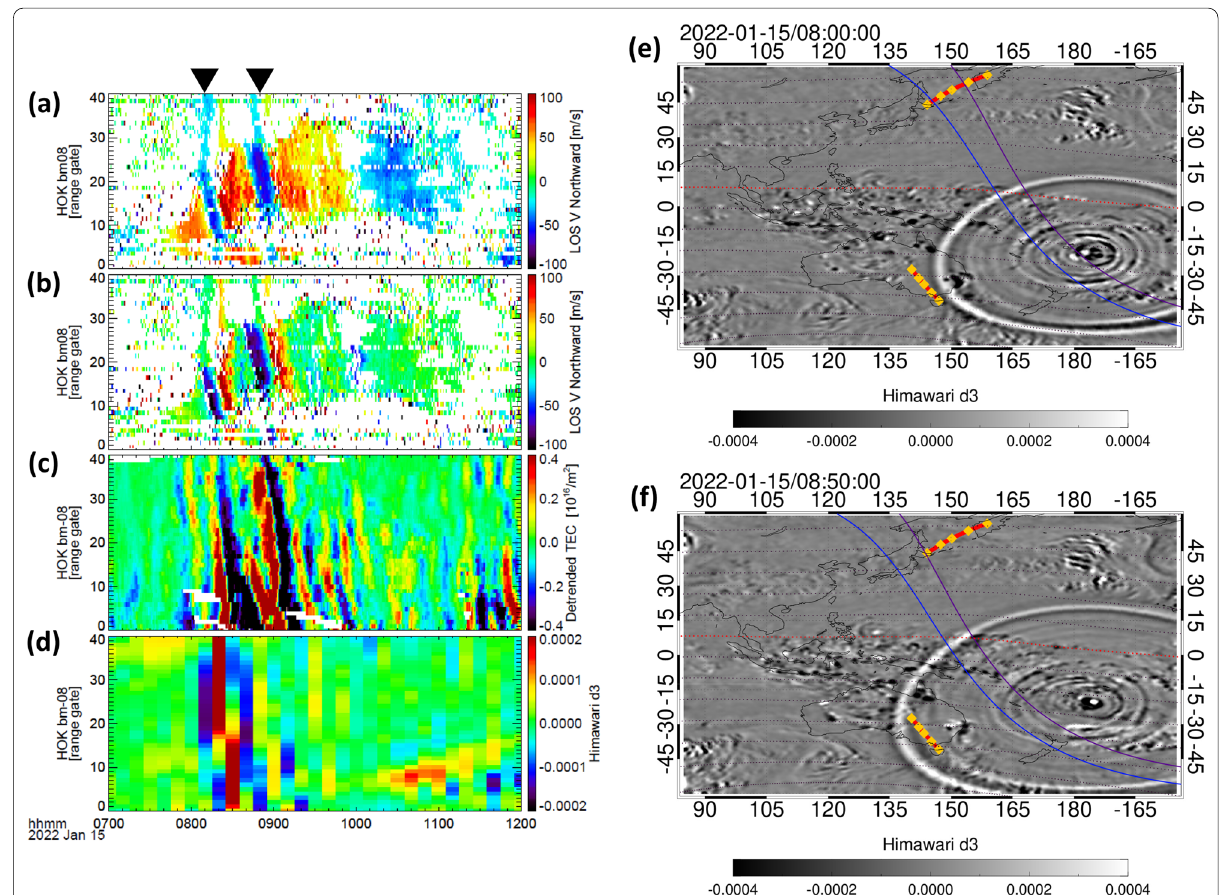
Fig. 4 Range-time plots of a northward component of line-of-site plasma velocity, b 15-min high-pass filtered plasma velocity, c and d detrended TEC and normalized temperature deviation (d3) at the magnetic conjugate points of the beam-08 direction in the Southern Hemisphere, e and f two-dimensional maps of d3 in geographic coordinates. The two red curves with the yellow markers every 10 range gates indicate the locations of line-of-site of beam-08 of the SuperDARN Hokkaido east radar and their magnetic conjugate points in the Southern Hemisphere. The five orange points on these curves indicate the number of range gate from 0 to 40. The two triangles above the left panel correspond to the time of two-dimensional maps of d3. The blue and purple curves in panels ( e ) and ( f ) indicate the sunset terminators at a height of 105 and 300 km,